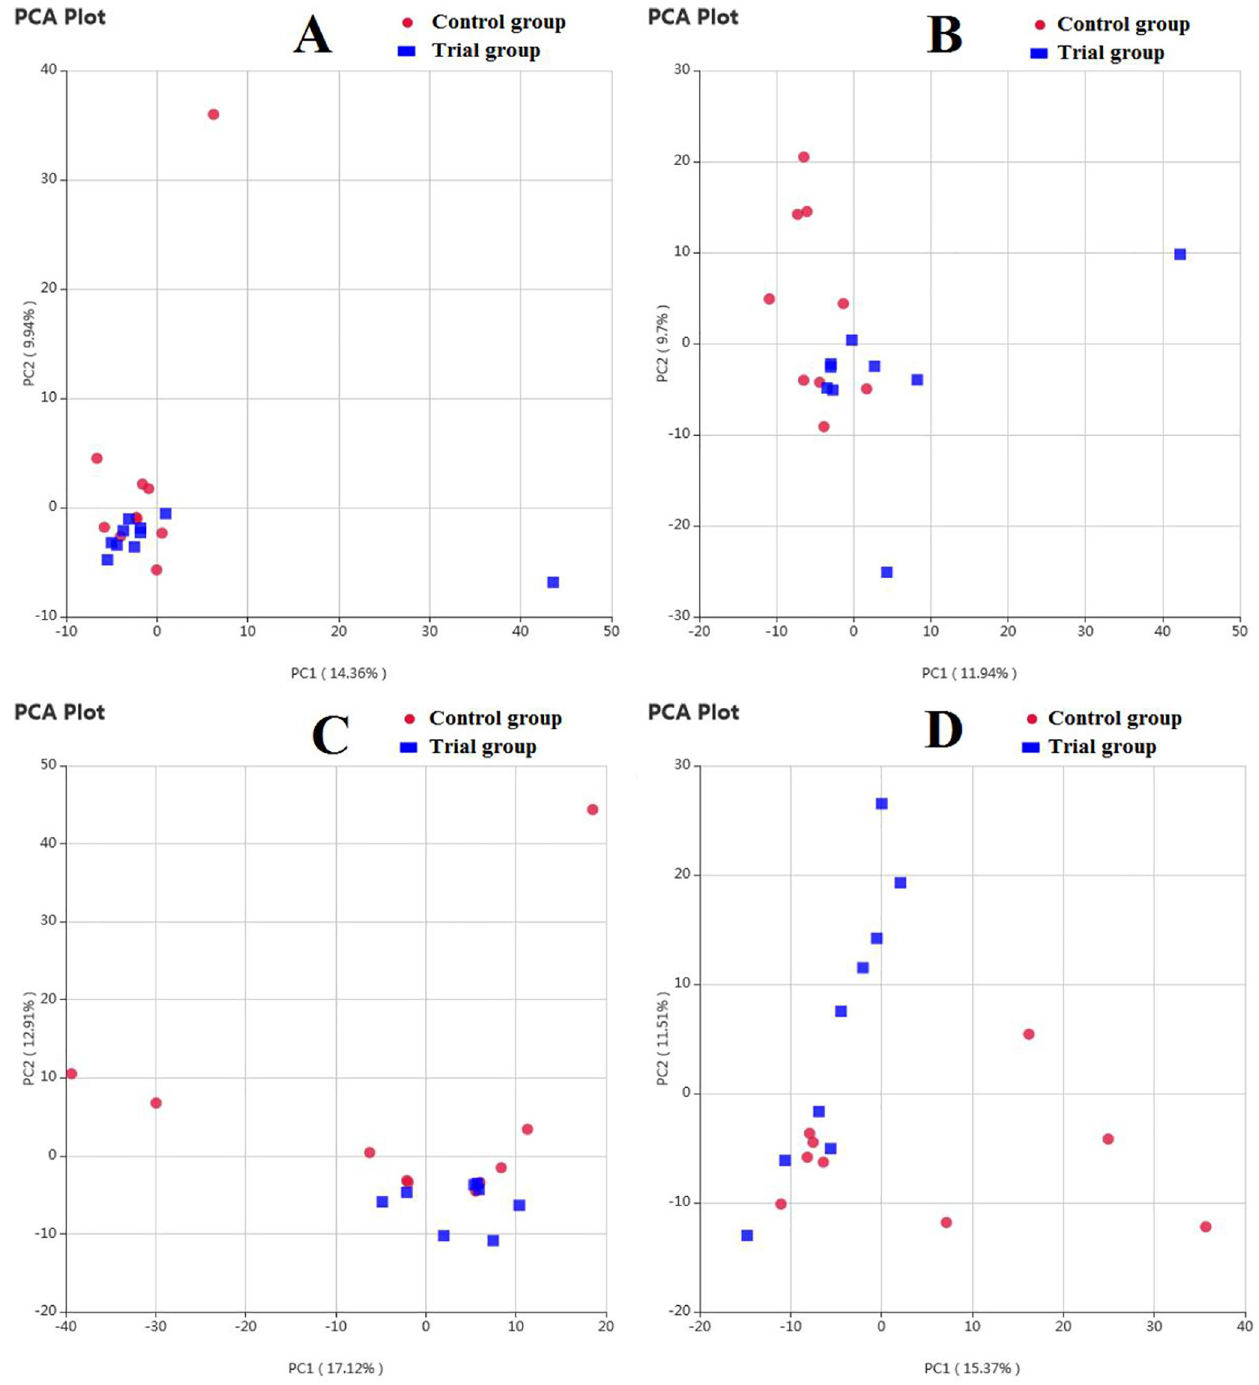
Fig 1. The PCA profile of bacterial flora in rat feces and intestinal digesta. A) 7 d (feces); B) 21 d (feces); C) 35 d (feces); D) 35 d (intestinal). Red: Control group; Blue: Trial group.